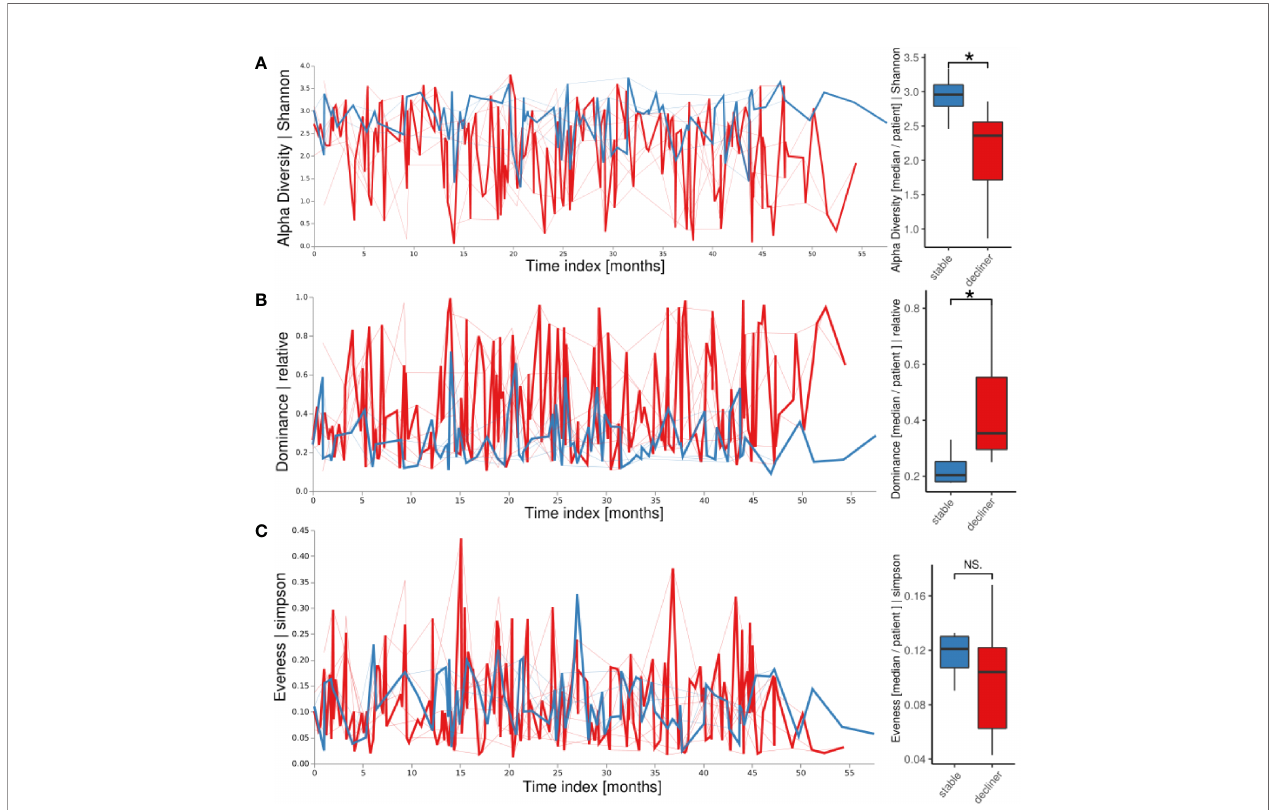
FIGURE 2 | Longitudinal volatility analysis and boxplot visualization of descriptive microbiome statistics grouped by the patient groups: Alpha diversity (A) , relative dominance (B) , and the evenness (C) . The thick lines represent how the variable changes over time in the patient group while the thin lines represent each patient. *p < 0.05, NS, not signi fi